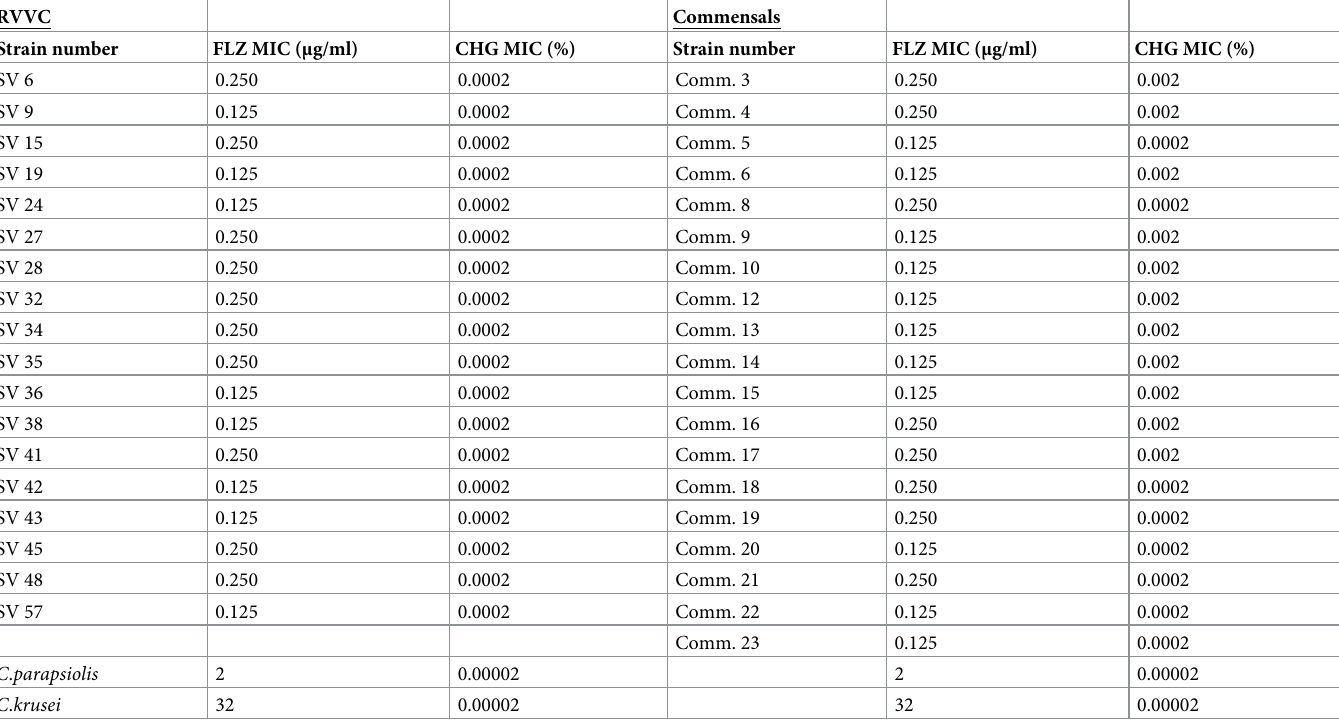
0.125 0.0002 Comm.